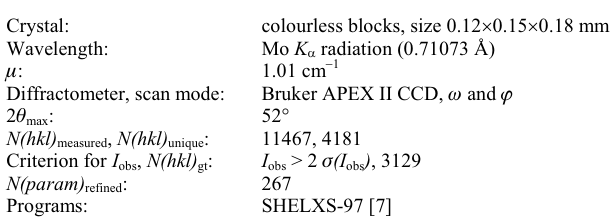
Table 1. Data collection and